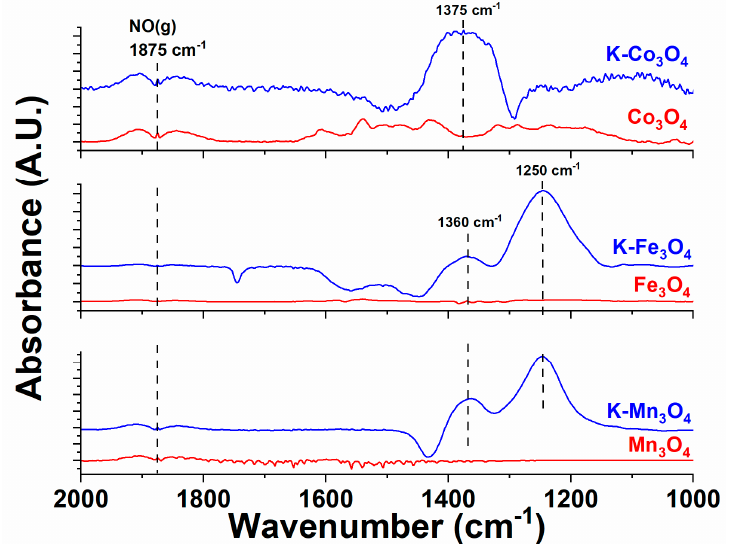
Figure 3. In situ Fourier transform infrared (FTIR) of transition metal spinels during NO adsorption with and without K (2 wt. %) at 300 °C.